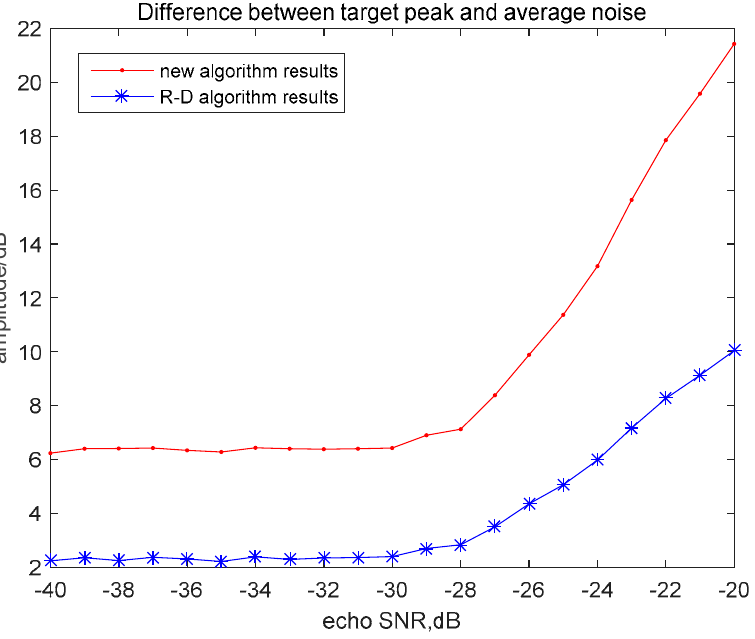
Figure 4. Difference between the target peak and the average noise platform ( N = 10 4 ).